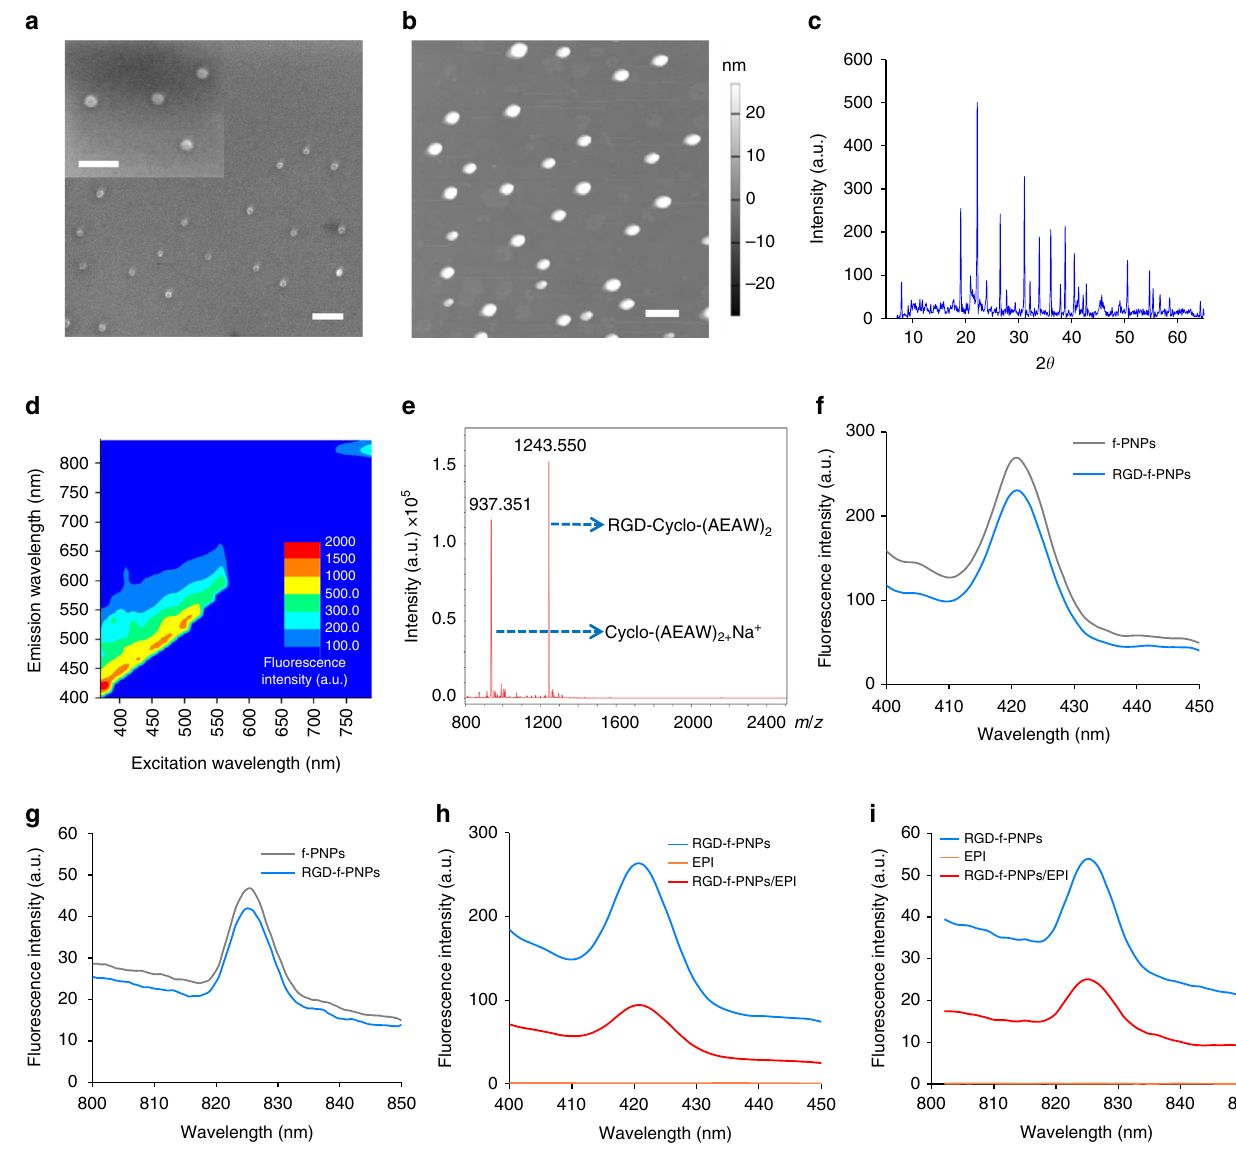
Fig. 2 Nanomorphological and optical properties of the f-PNPs and RGD-f-PNPs/EPI complex. a , b SEM and AFM image of the f-PNPs indicate an average diameter of ~28 nm, which is signi fi cantly smaller than most self-assembled peptide nanostructures reported in the literature. Scale bar: 100 nm. c PXRD spectrum with distinct sharp peaks and high intensities indicates well-ordered nanocrystal structure of the f-PNPs. d Fluorescence vs. excitation spectra indicating multiple emission signals under various excitation wavelengths. Both visible and NIR fl uorescence emissions were observed. e Mass spectra of RGD-f-PNPs after nanoparticle disassembly. The molecular weight of 1243.550 indicates the successful conjugation between RGD and cyclo[-( D -Ala- L -Glu- D -Ala- L -Trp) 2 -] peptides. The molecular weight of 937.351 indicates the unconjugated cyclo[-( D -Ala- L -Glu- D -Ala- L -Trp) 2 -] peptides. f , g Fluorescence emission spectra of the RGD-f-PNPs. Excitation wavelengths are 370 and 760 nm, respectively. No obvious fl uorescence change was observed for f-PNPs after the RGD modi fi cation. h , i Fluorescence emission spectra of the EPI alone, RGD-f-PNPs before and after EPI loading. Excitation wavelengths are 370 and 760 nm, respectively. Obvious fl uorescence quenching was observed after EPI